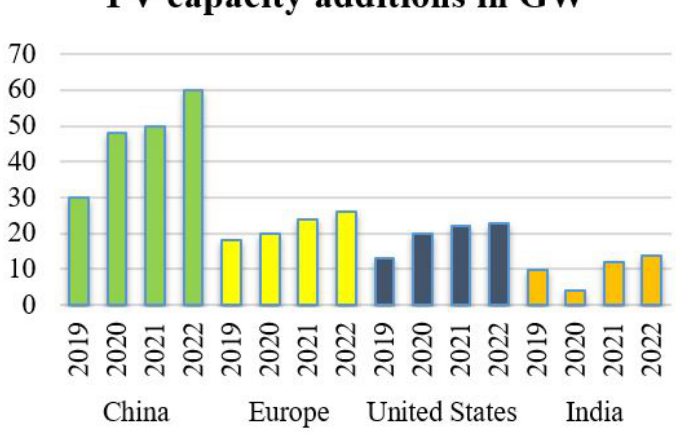
Figure 1. Photovoltaic capacity additions in GW.